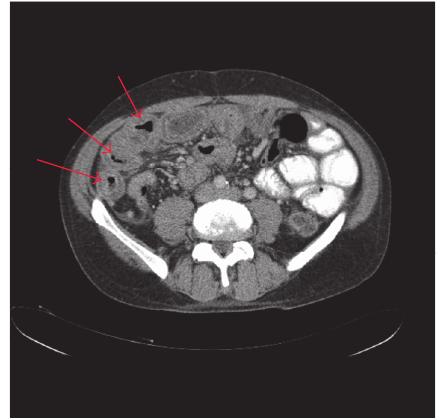
Figure 2: CT abdomen axial view showing thickening of the small bowel wall as indicated by the arrows. March 2011.